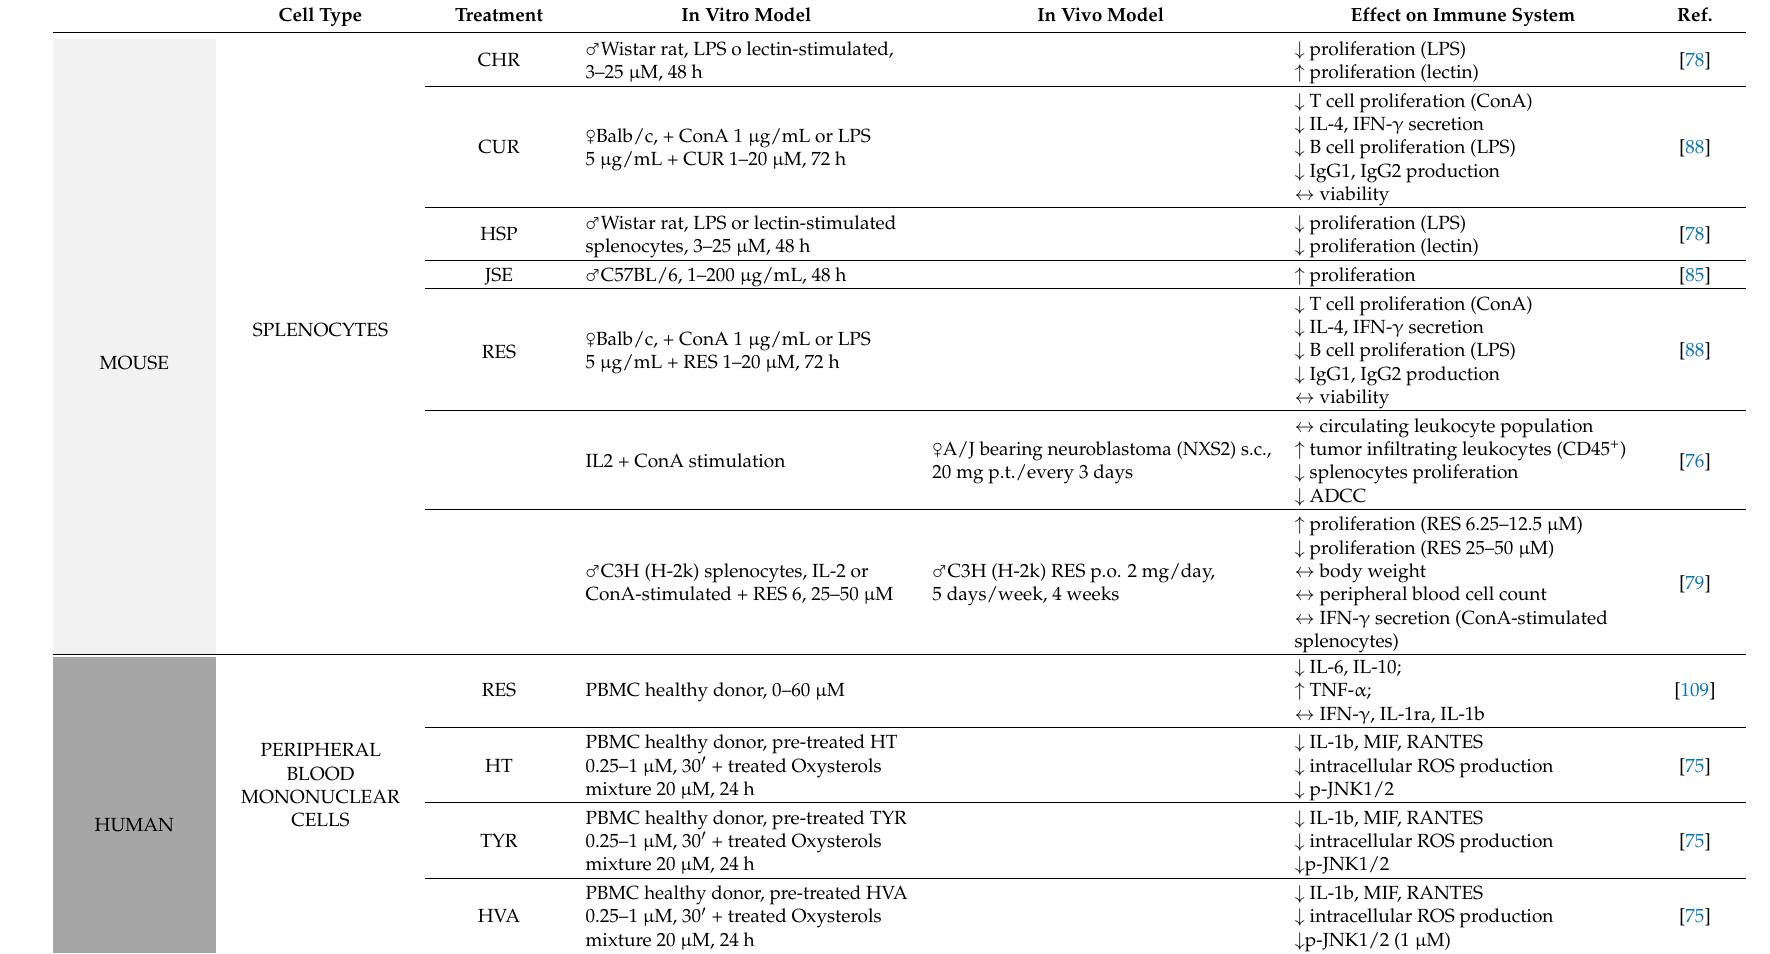
Table 1. In vitro and in vivo effect of polyphenols on immune